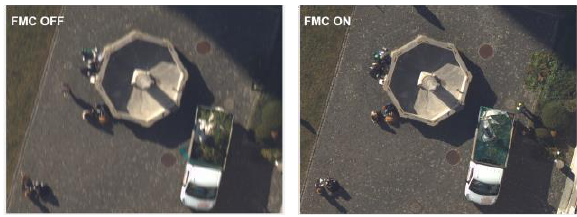
Figure 4: Leica MFC150 with FMC off/on - showing the benefit of FMC for long exposure at low sun angle (1/200 sec at 120 kn)